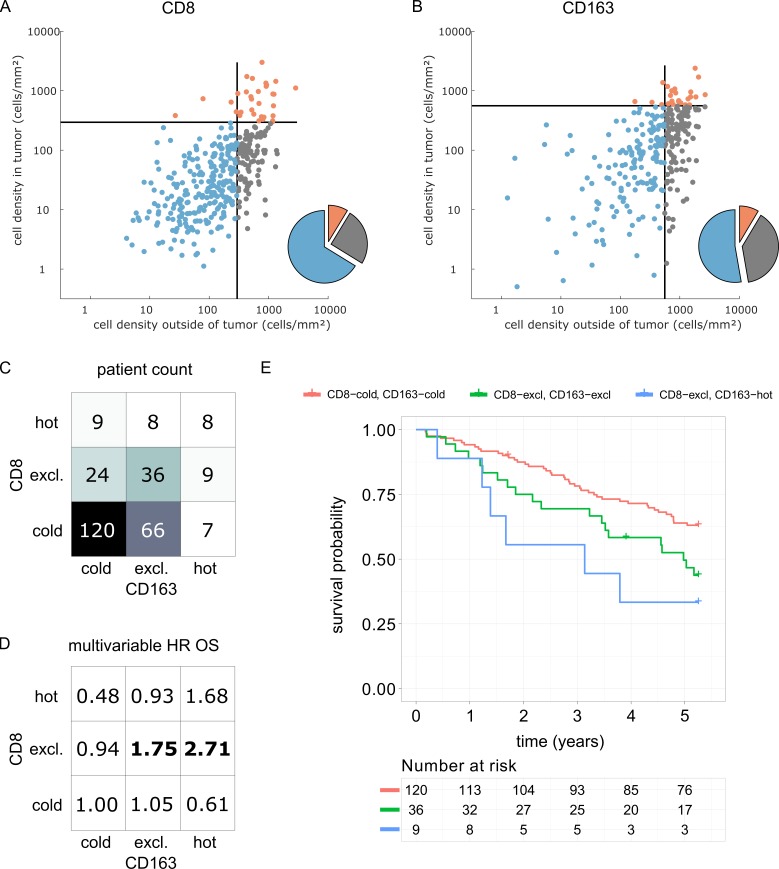
Prognostic value of the myeloid-lymphoid topography in primary colorectal cancer (CRC) in the DACHS cohort.In a validation cohort of N = 287 colorectal cancer patients (N = 286 with follow-up data) from the DACHS study, CD8 and CD163 staining of the primary surgical sample was correlated to clinical outcome (overall survival) using the cutoffs from the pan-cancer cohort. (A) As in the CRC subgroup in the pan-cancer cohort, CD8-cold was the most prevalent phenotype, followed by CD8-excluded. (B) A similar distribution of phenotypes was observed for CD163+ macrophages. (C) In the bivariate analysis for CD8 and CD163, most patients had cold and excluded phenotypes for both antigens. (D) For each of these nine phenotypes, the hazard ratio (HR) for death of any cause (inverse overall survival, OS) was derived from a multivariable Cox proportional hazard model (covariates UICC stage, age and sex). Bold HR indicates statistically significant findings with p<0.05. Bivariate analysis of both antigens is essential for risk stratification as CD8 and CD163 phenotypes show non-trivial interaction. Raw data for panel D are shown in Supplementary file 5. (E) The Kaplan-Meier plots for the reference groups (CD8-cold CD163 cold) and the two significant groups (‘CD8-excl., CD163 excl’ and ‘CD8 excl., CD163 hot’) show significant differences in overall survival. These differences are not captured by univariate, but only by this bivariate stratification system. Log rank p-value=0.019.